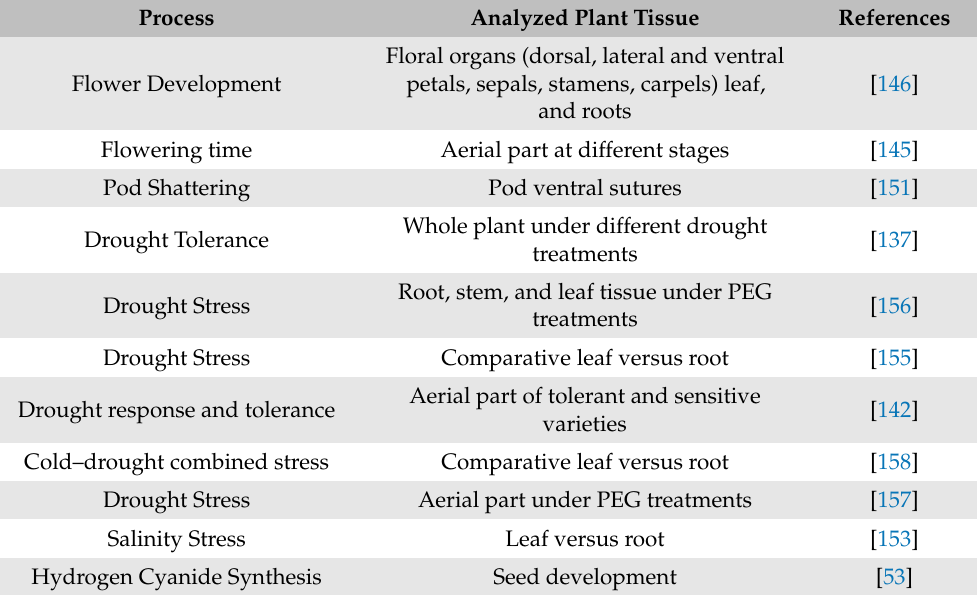
Table 3. Developmental, metabolic, or stress processes with transcriptomic analysis in Vicia sativa . Analysis was performed at indicated plant tissue or developmental